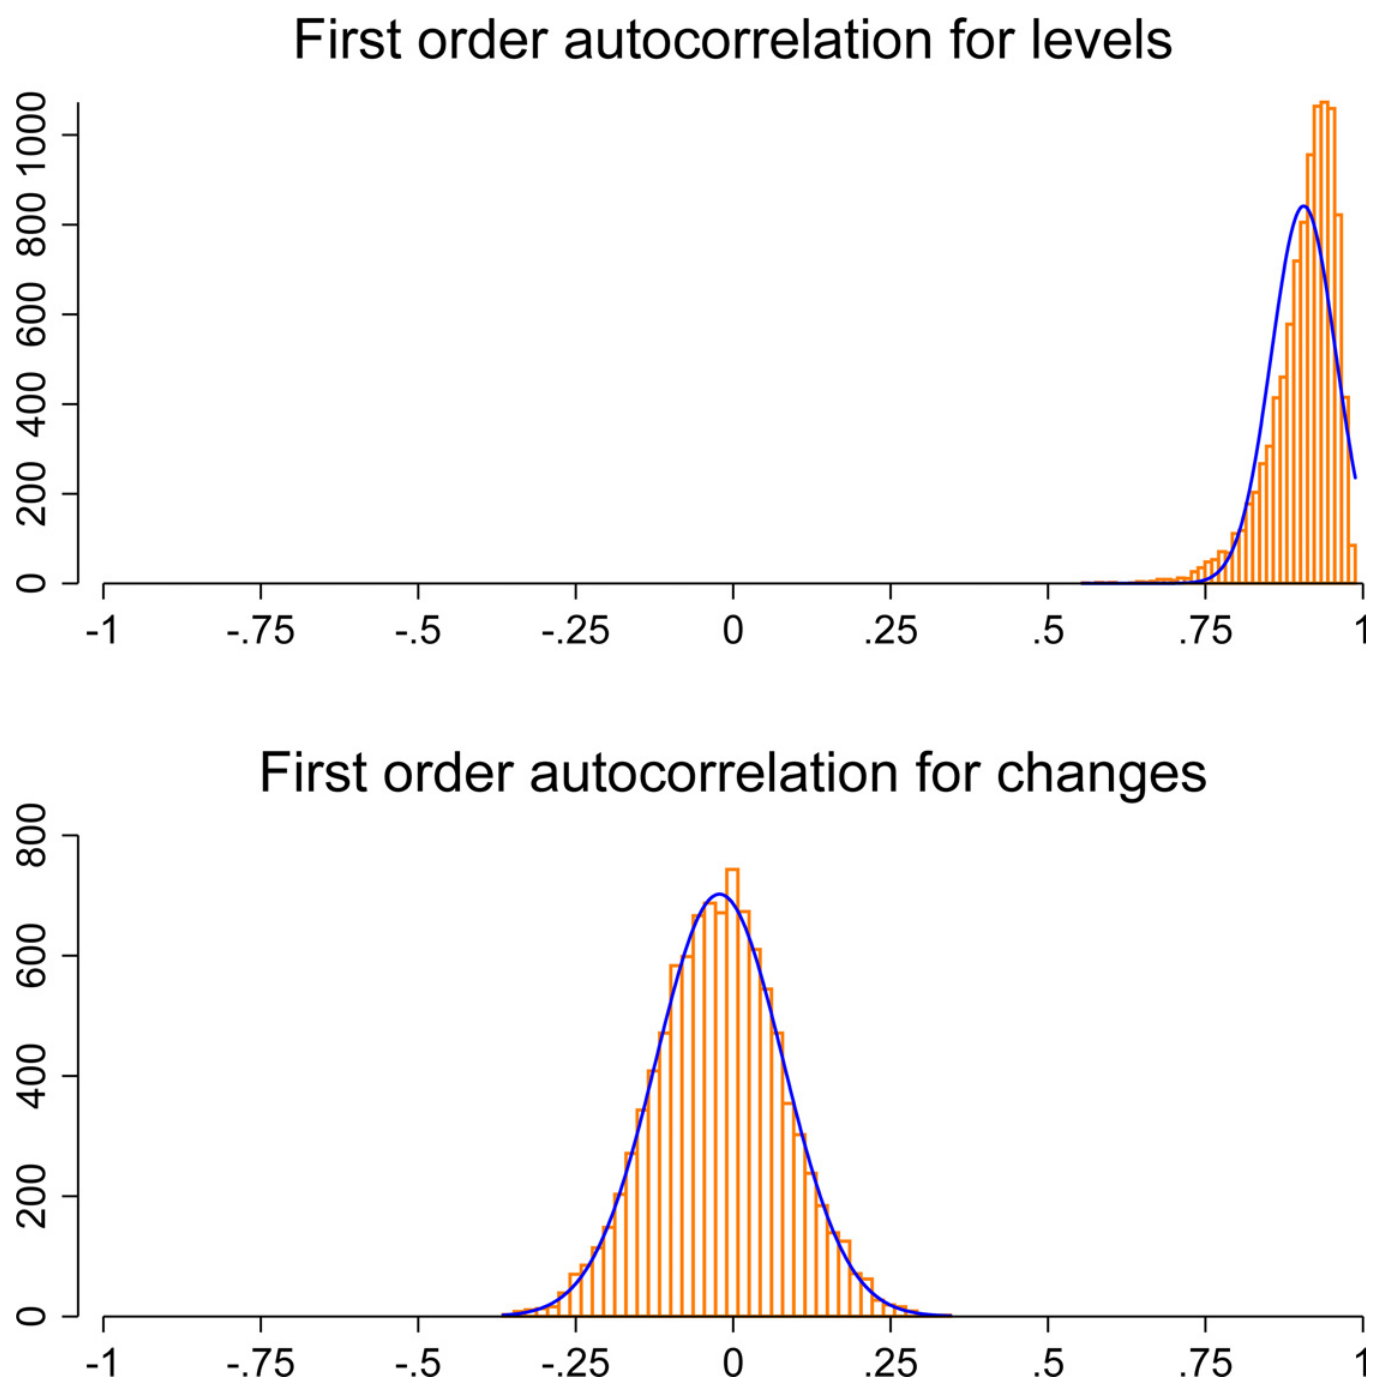
Fig 5. Correlations of current and lagged residuals of a regression of the 10,000 simulated random walks with drift on the annual global mean seal level. Top: Histogram for levels. Bottom: Histogram for year-to-year changes. The height of the bars in both histograms represents the number of cases in the category. Blue lines: scaled normal